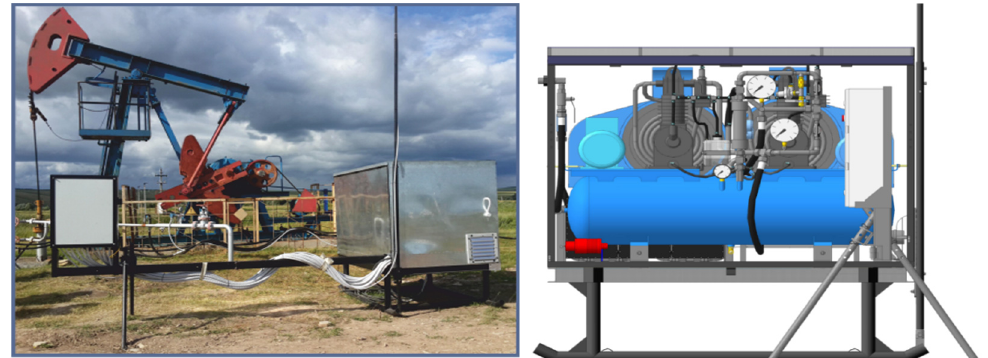
Figure 1. A set of equipment for gas extraction from wells (KOGS).